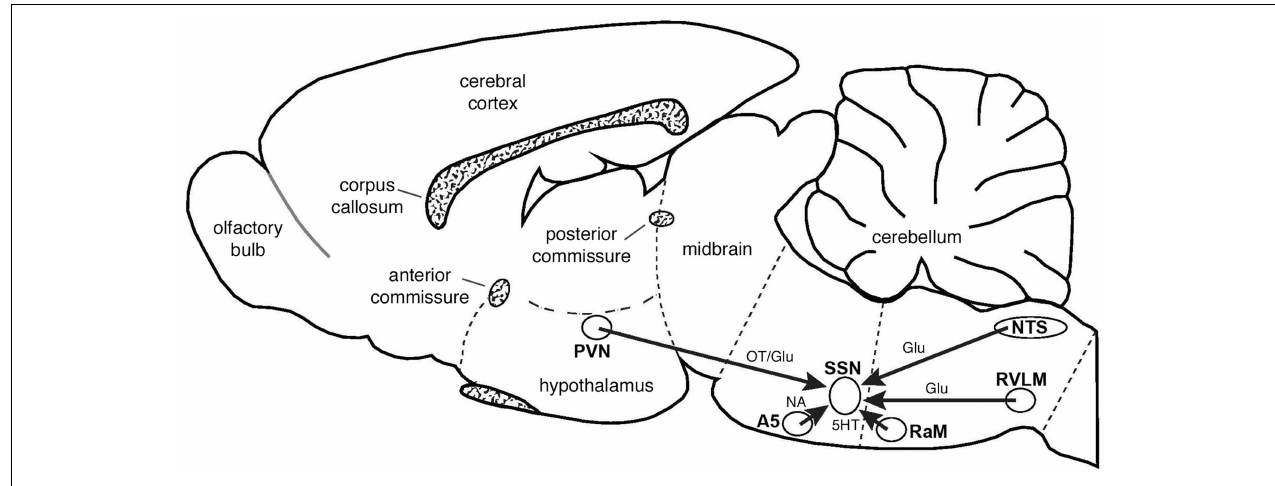
FIGURE 13 | Schematic summarizing the major inputs to SSN and their neurotransmitters, as interpreted from the present studies or from prior findings from the literature, as reviewed